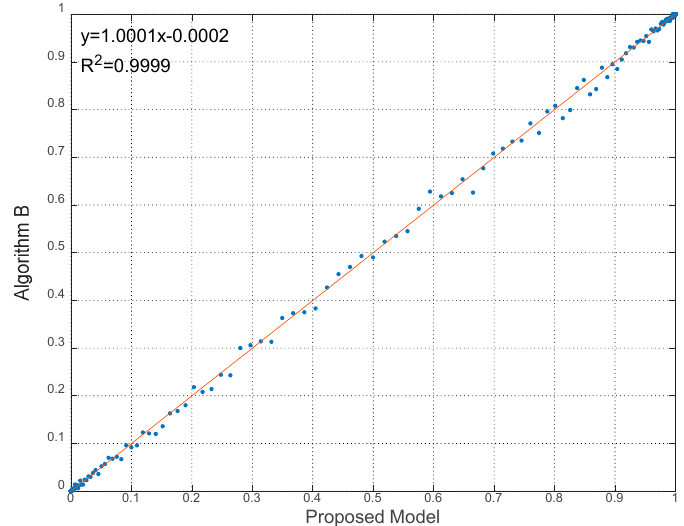
Figure 15. Linear regression of robustness results in Experiment 2.